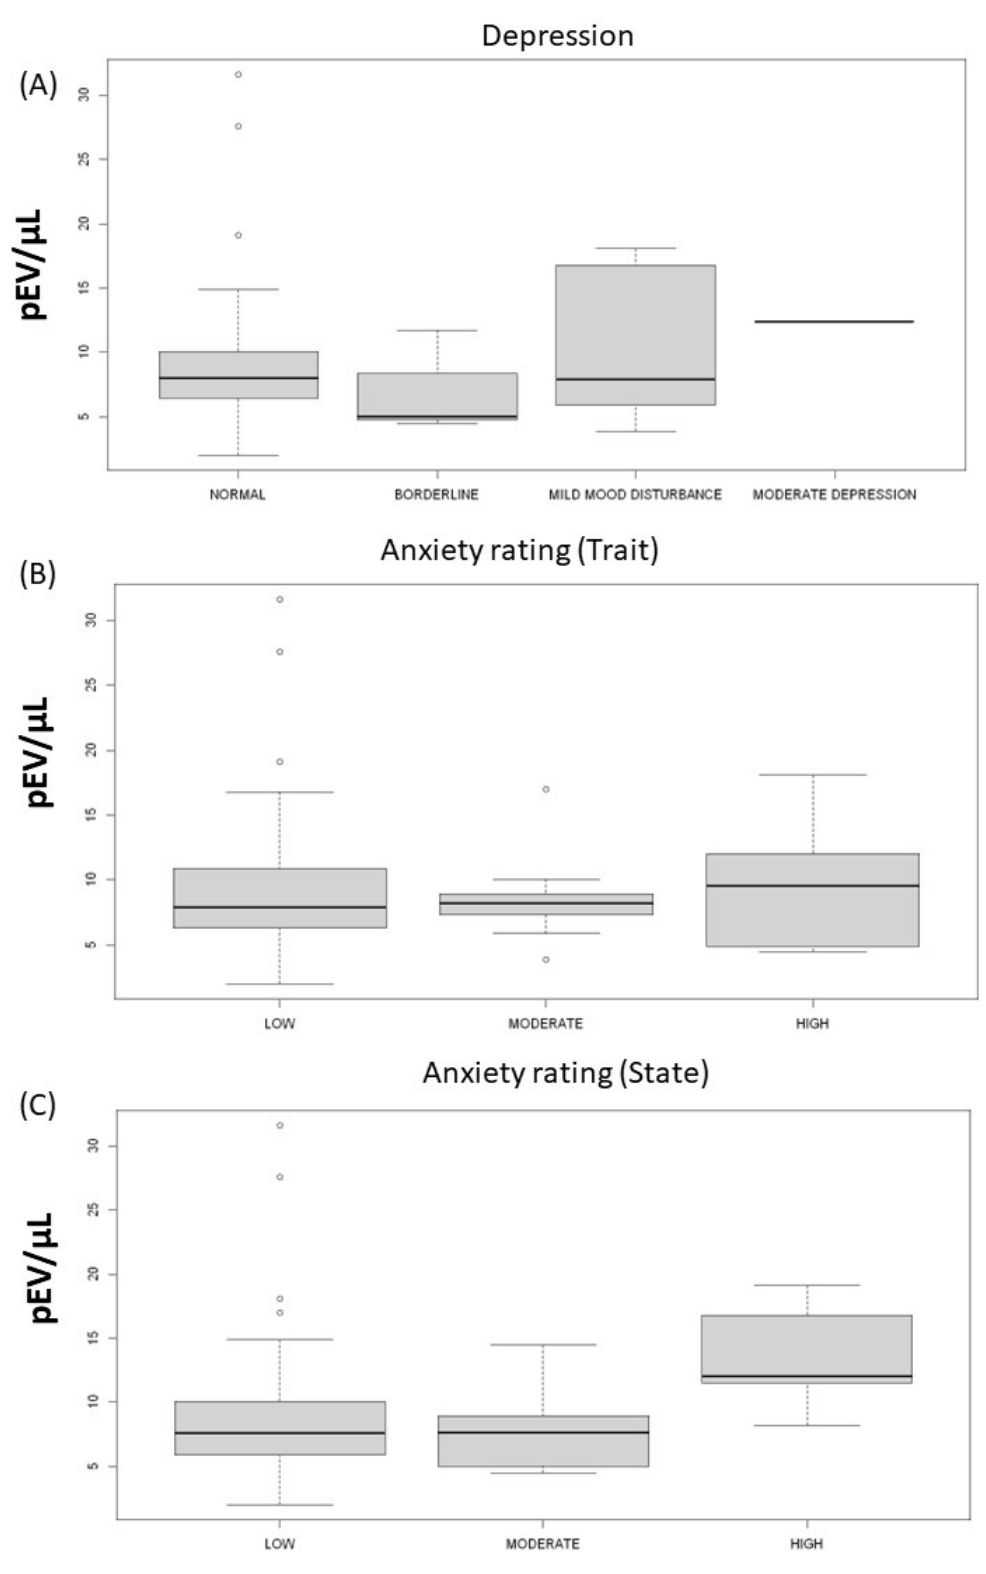
Figure 4. Platelet derived extracellular vesicles and emotional evaluation. ( A ) Boxplot of depres- sion categories and extracellular vesicles ( p = 0.83). ( B ) Boxplot of anxiety rating (trait) categories and extracellular vesicles ( p = 0.88). ( C ) Boxplot of anxiety rating (state) categories and extracellular vesicles ( p =